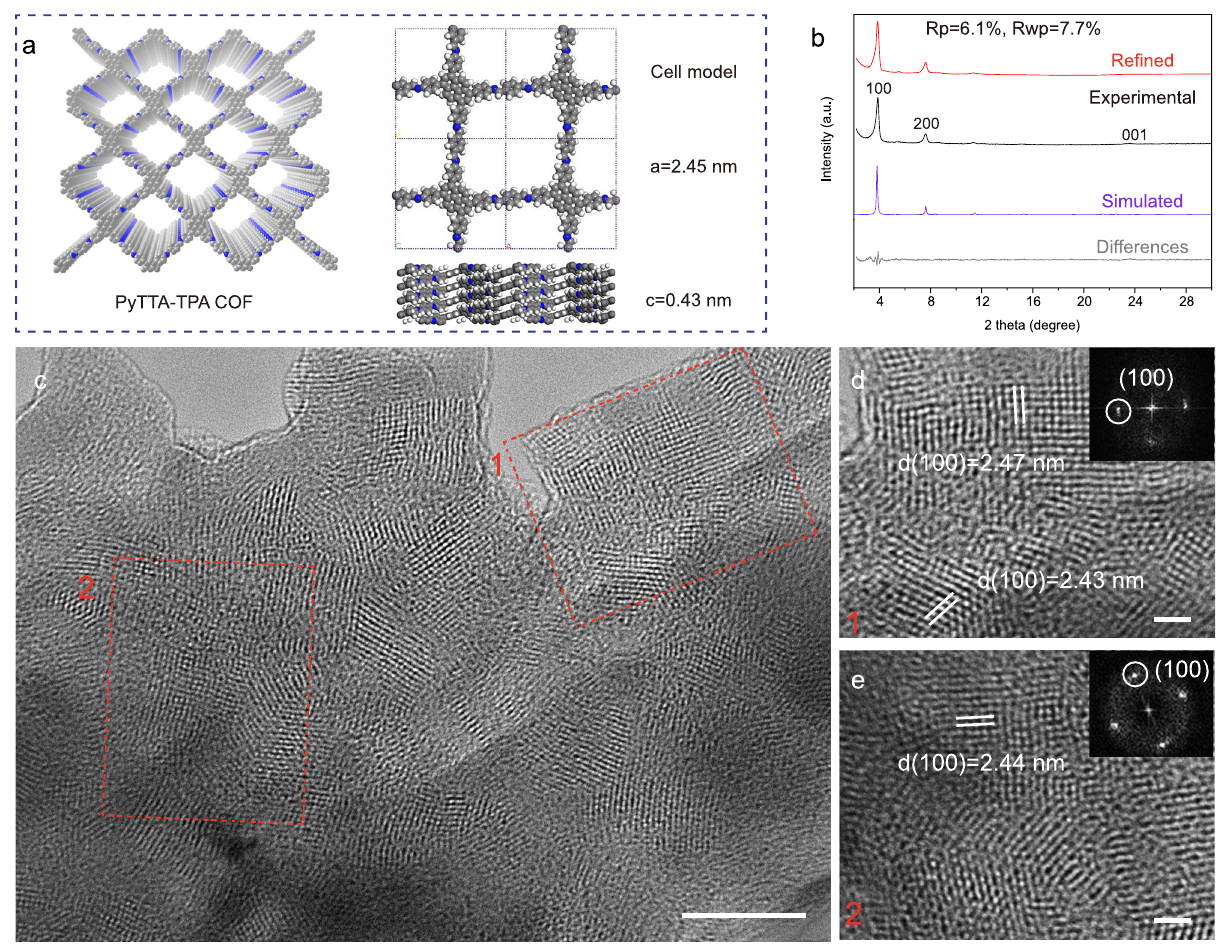
Fig. 3 GIWAXS and TEM characterizations of PyTTA-TPA COF fi lms. a Simulated molecular structure of PyTTA-TPA COF based on AA-stacking mode. b Theoretical and experimental GIWAXS of the PyTTA-TPA COF fi lm with a thickness of ~30 nm. c TEM of the PyTTA-TPA COF fi lm with a thickness of ~13 nm. Scale bar 50 nm. d , e TEM of the PyTTA-TPA COF fi lm captured from regions in c . Scale bar 10 nm. The inset showed the fast Fourier transformation (FFT)